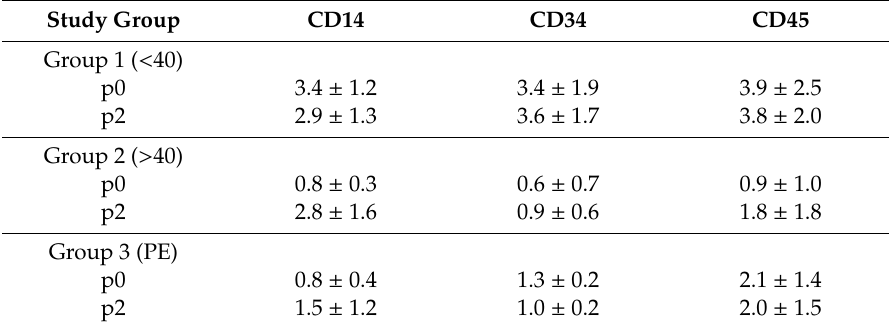
Table 2. Hematopoietic markers of hAMSCs belonging to the three study